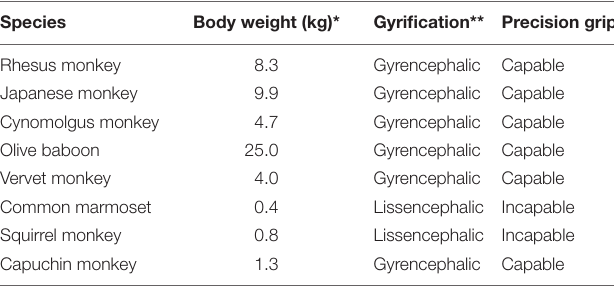
TABLE 1 | Non-human primate species used to investigate adaptive mechanisms after